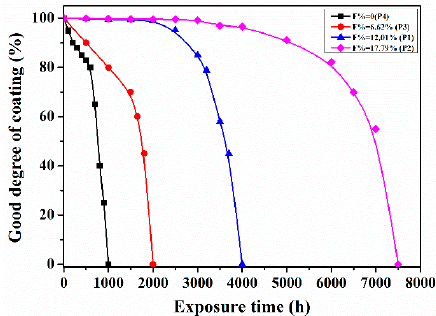
Figure 8. Accelerated weathering test of coatings with different fluoride contents.